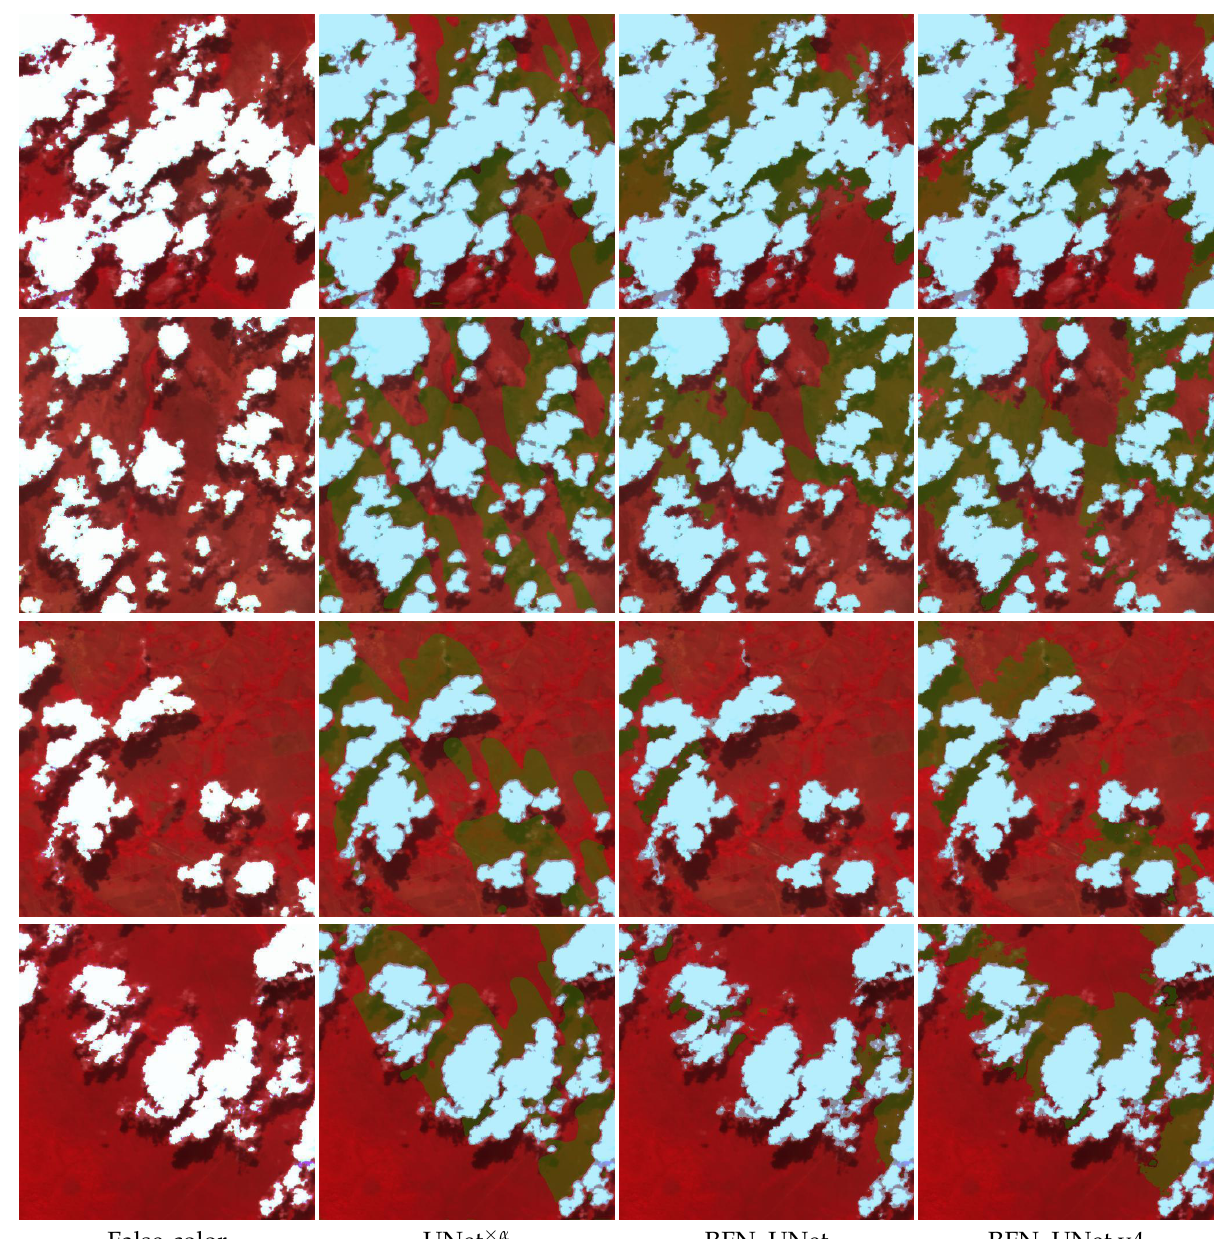
False-color UNet × α RFN. UNet RFN. UNet v4 Figure 4. Illustrations of segmentation proposals from a local perspective (1). The typical patches are drawn from GF1WFV1.16m.2014267223114.21LTD.FAGUO1.SR.tiff, the false-color images (bands 4, 3, and 2) and the segmentation proposals of which, yielded respectively by UNet × α , our Refined UNet, and v4, are presented. It can be seen that the edge-refined labels of cloud and shadow regions are generated by both Refined UNet and v4, in comparison with UNet × α giving region-accurate labels. Such illustrations further support the edge-refined efficacy of our sophisticated